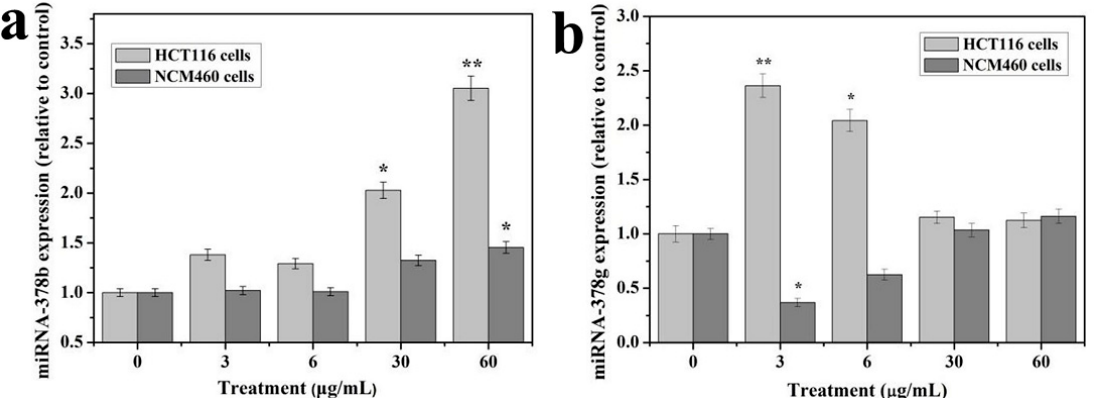
Figure 8. The expression patterns of microRNAs 378b and 378g at 3 and 60 μ g/mL treatments in HCT116 and NCM460 cell lines. ( a ) Expression of microRNAs 378b; ( b ) Expression of microRNAs 378g. The experiments were carried out as in triplicate and data presented are in represent mean values. * indicates means p < 0.05, ** indicates means p < 0.01.